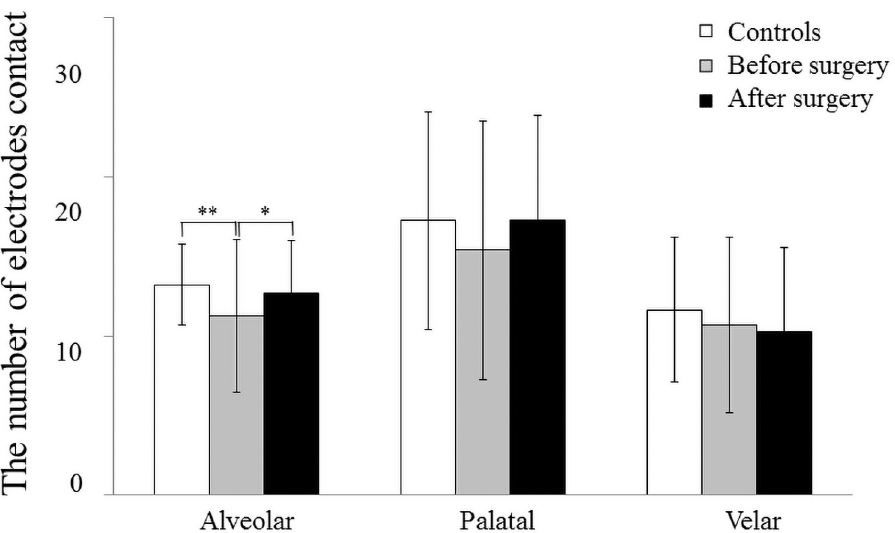
Fig 6. Mean and standard deviation in the number of electrodes contact of alveolar, palatal and velar part in the controls, patients before surgery, and after surgery. 0.3 seconds before complete tongue-palatal contact ( � : p < 0.05).